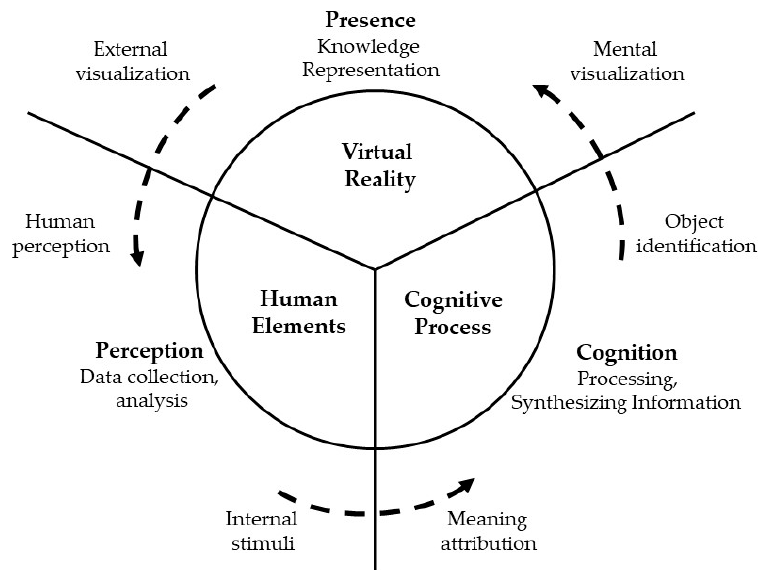
Figure 1. Human factors, cognitive aspects, and knowledge representation in building